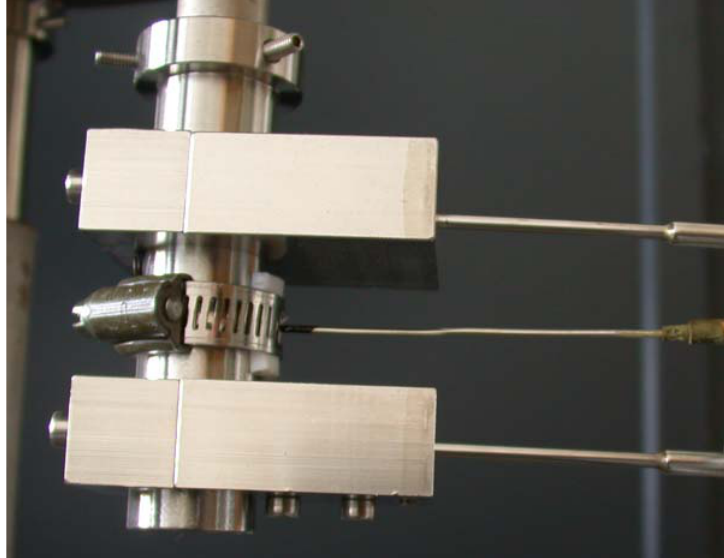
Figure 3. Array of three temperature sensors in measuring cells which can optionally used as diffusion